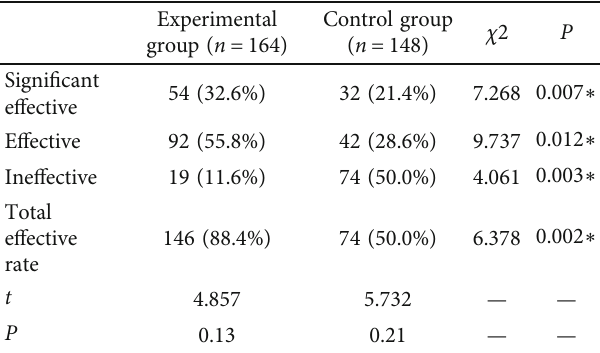
Table 4: Comparison of clinical therapeutic e ff ect between the two groups ( n ð % Þ ).